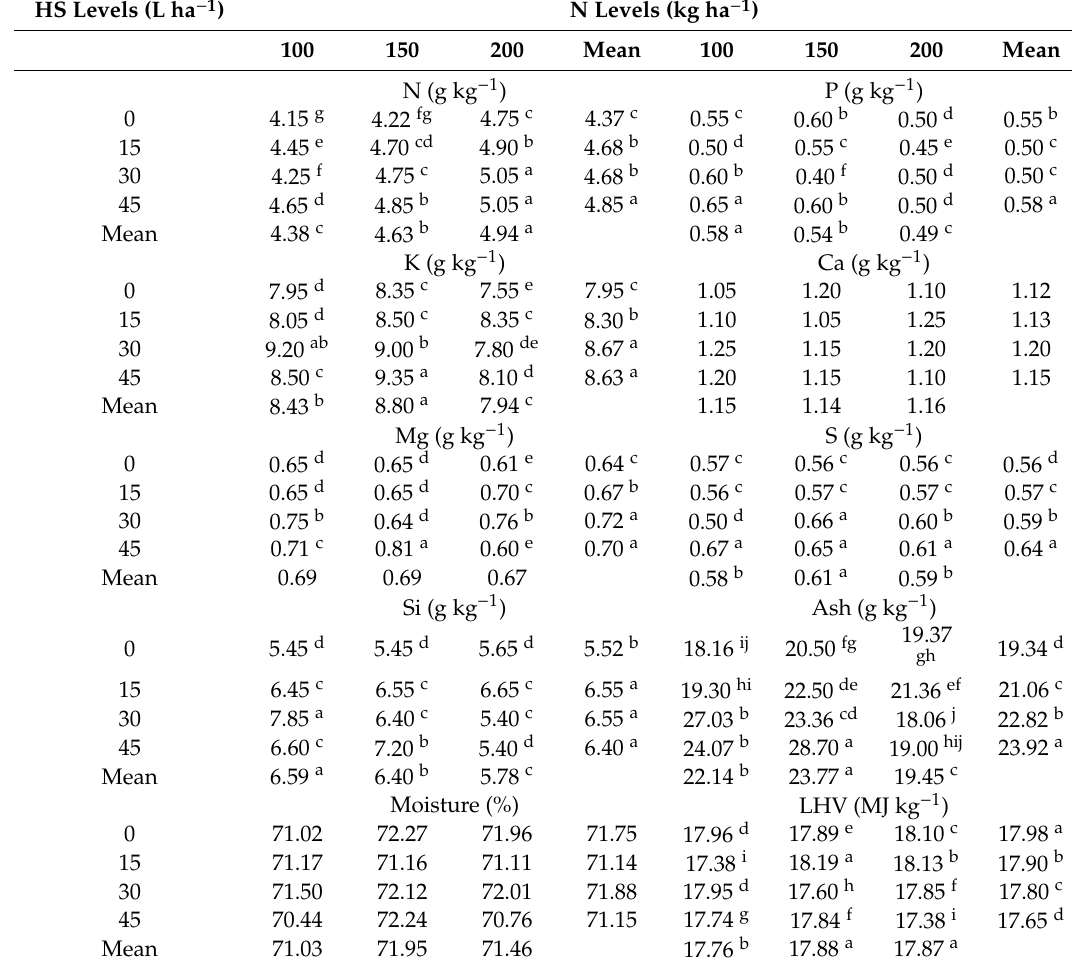
Table 5. E ff ects of the N and HS applications on mineral, moisture, and ash concentrations and cell wall composition of sweet sorghum bagasse (data over two